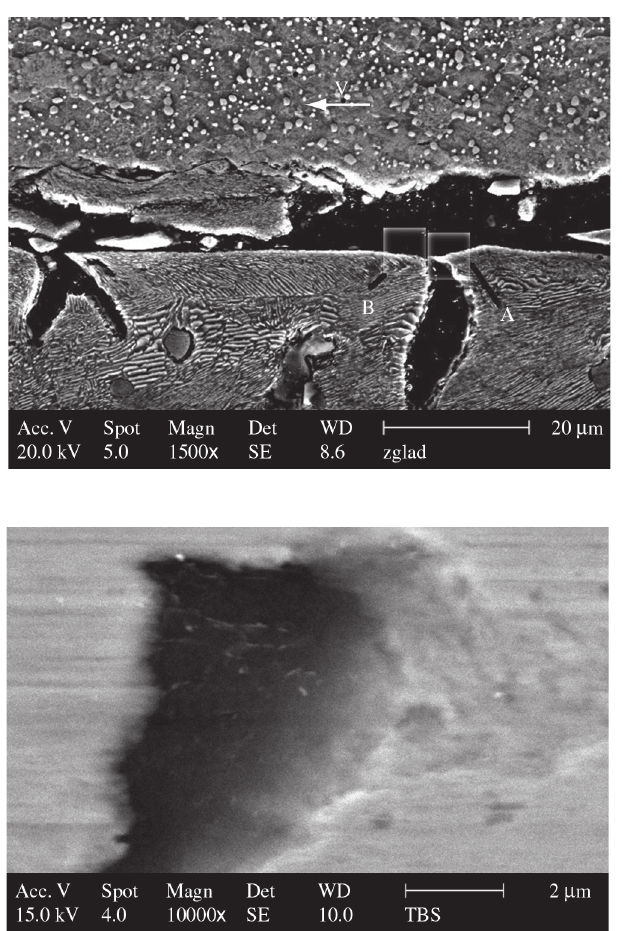
Figure 10. Overlaping and compressing of material in the zone of border.